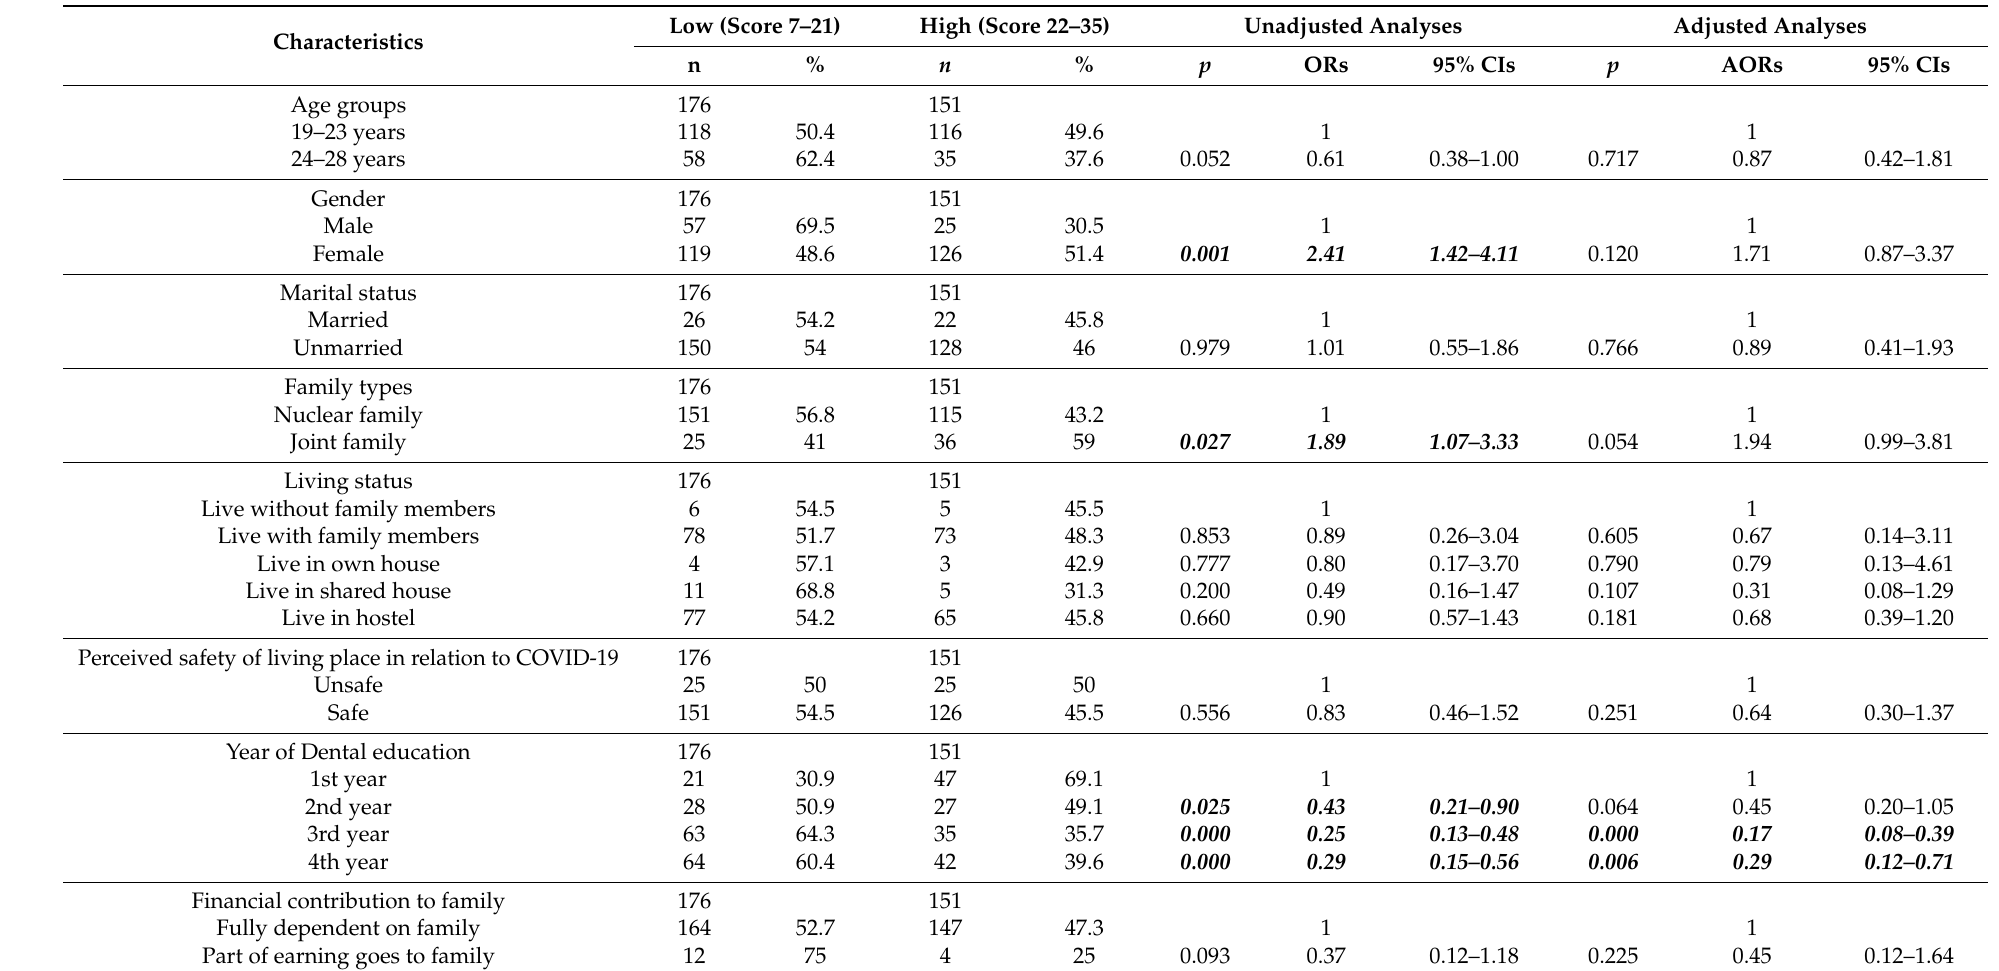
Table 6. Predictors for fear of COVID-19 among the study population (based on FCV-19S score).